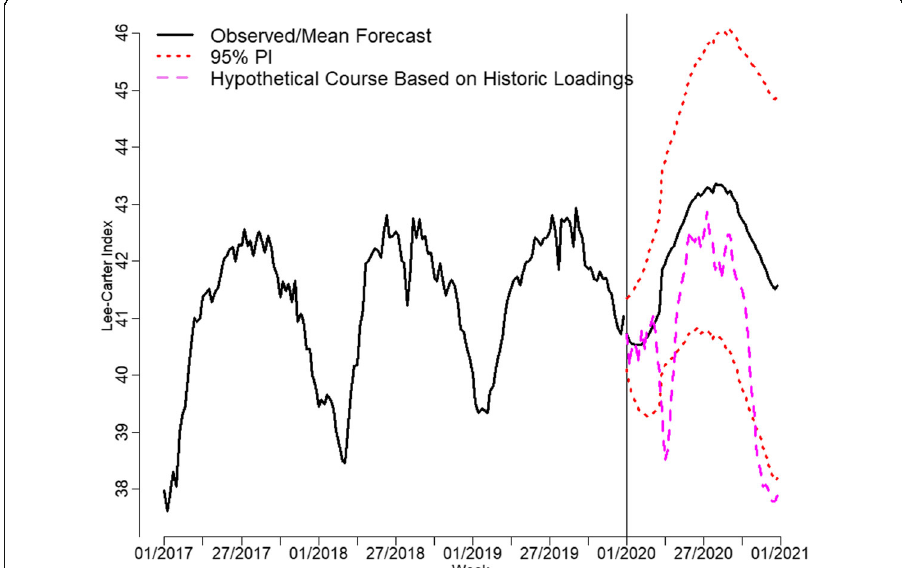
Fig. 5 Forecast of Lee-Carter Index for 2020 with 95% PIs and actual course